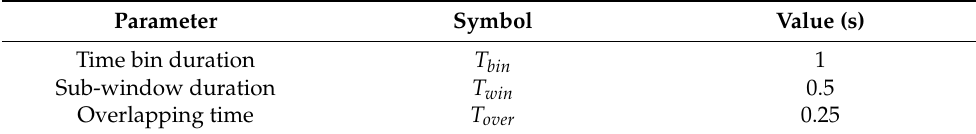
Table 3. Parameters used in the algorithm for the estimation of the power spectrum of rail irregularity. Parameter Symbol Value (s) Time bin duration T bin 1 Sub-window duration T win 0.5 Overlapping time T over